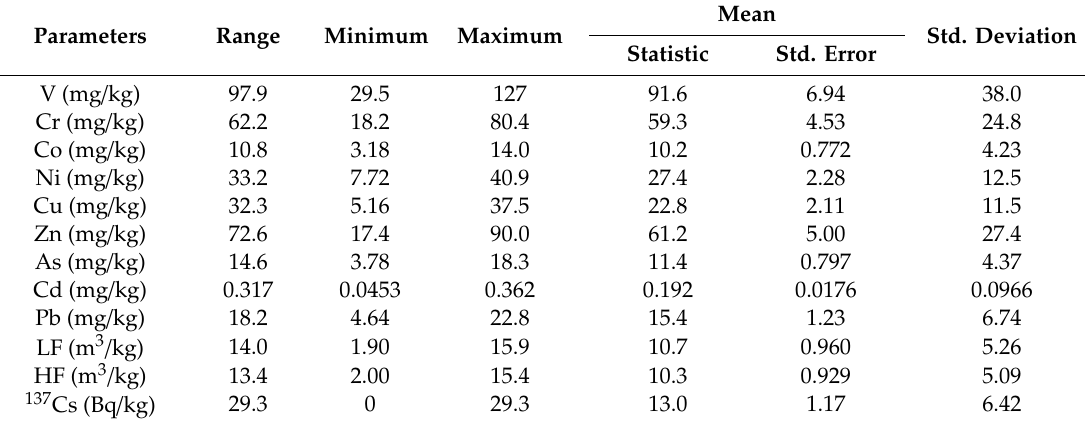
Table 2. Summary statistics for 12 environmental parameters: 137 Cs, magnetic susceptibility (MS) with high (HF) and low frequency (LF) and potentially toxic elements (PTEs) in the North Aral Sea sediment